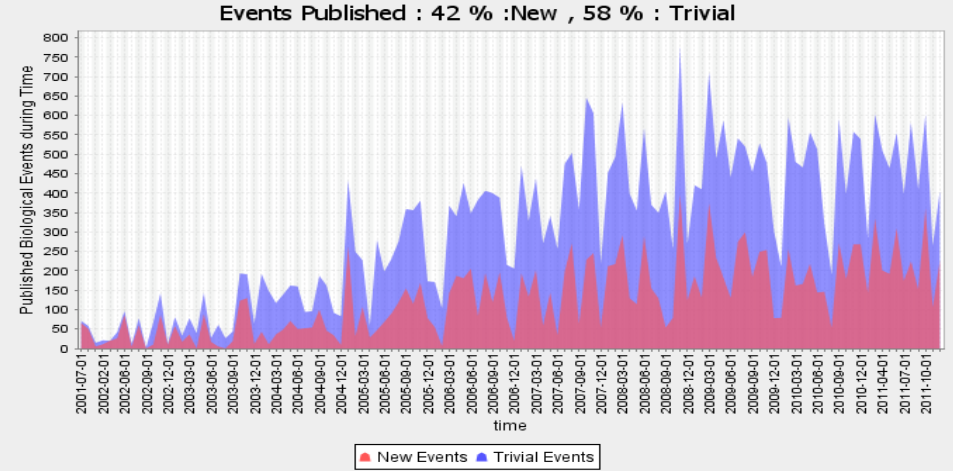
Figure 8. Proportion of background events (blue shape) vs. non background events (red shape) published periodically during the Hepcidin